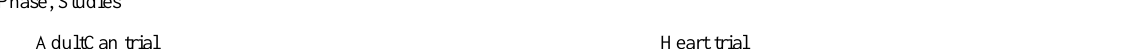
Table 1. The procedure at commencement and follow-up data collection in AdultCan and Heart trials. Phase,